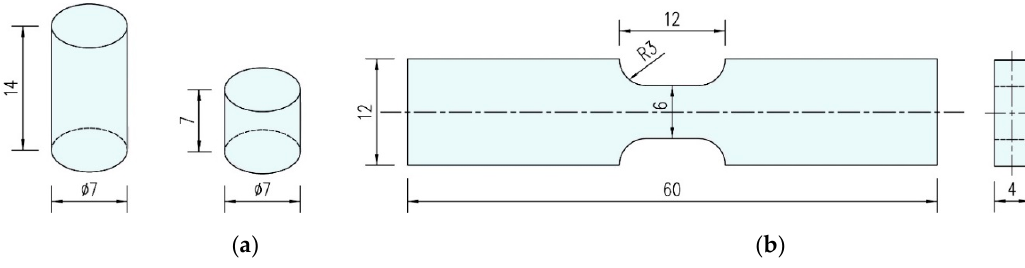
Figure 2. Geometric size of test piece (in mm): ( a ) compression specimens, ( b )tension specimen.